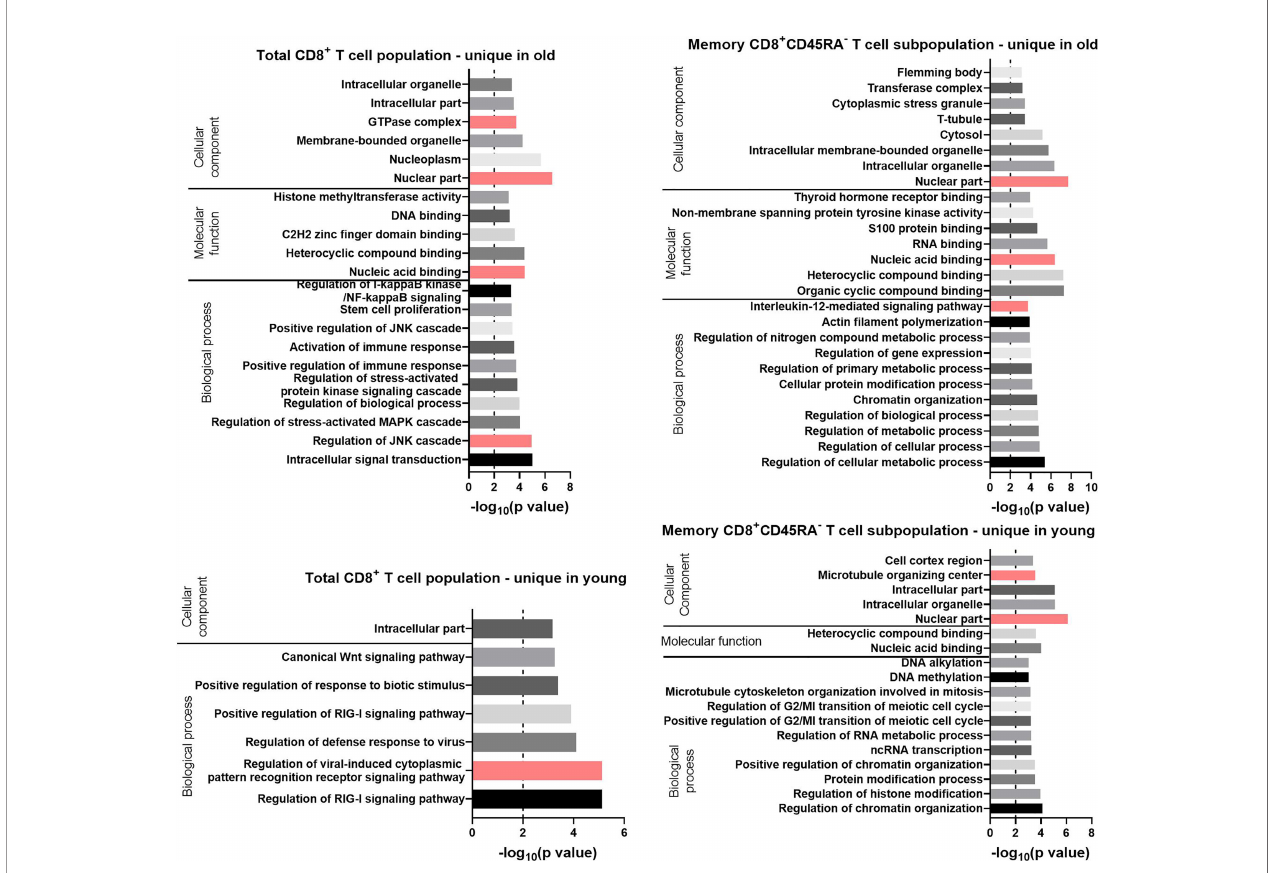
FIGURE 7 | GO terms for the uniquely expressed transcripts retrieved by GOrilla in total CD8 + T cells and CD8 + CD45RA - memory T cells in old and young donors. All transcripts were ranked according to the normalized mean of the counts for all preparations. The resulting GO terms are classi fi ed as biological process, molecular function, or cellular component. The dotted line is indicating − log 10 (p value) = 2, which corresponds to a p value of